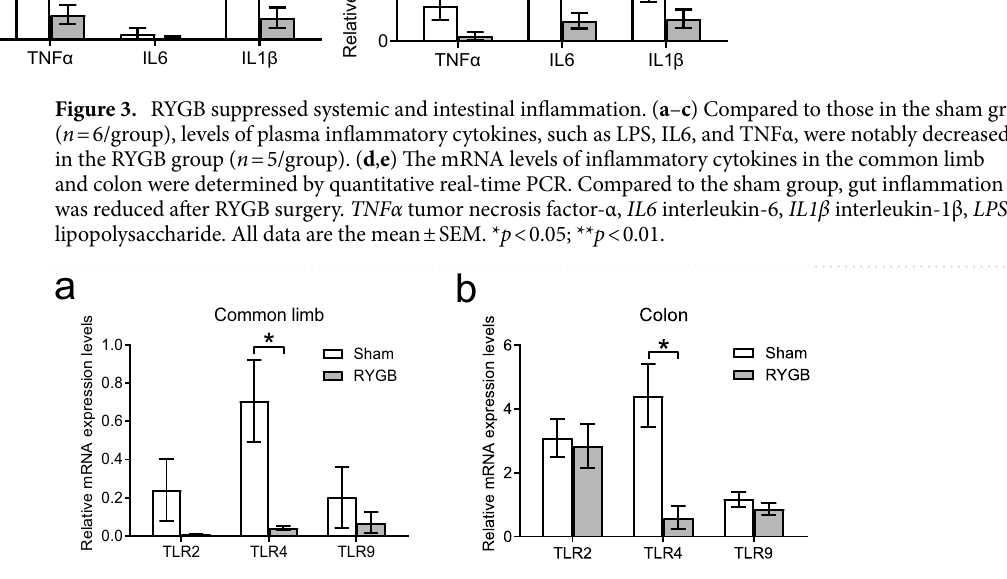
Figure 4. RYGB altered the expression levels of TLRs in the intestine. ( a , b ) Quantitative real-time PCR analysed the mRNA levels of TLRs. The mRNA expression levels of TLR4 were markedly downregulated in the common limb and colon of mice in the RYGB group ( n = 5/group) compared to the sham group ( n = 6/group). TLR2 toll-like receptor-2, TLR4 toll-like receptor-4, TLR9 toll-like receptor-9. All data are the mean ± SEM. * p <